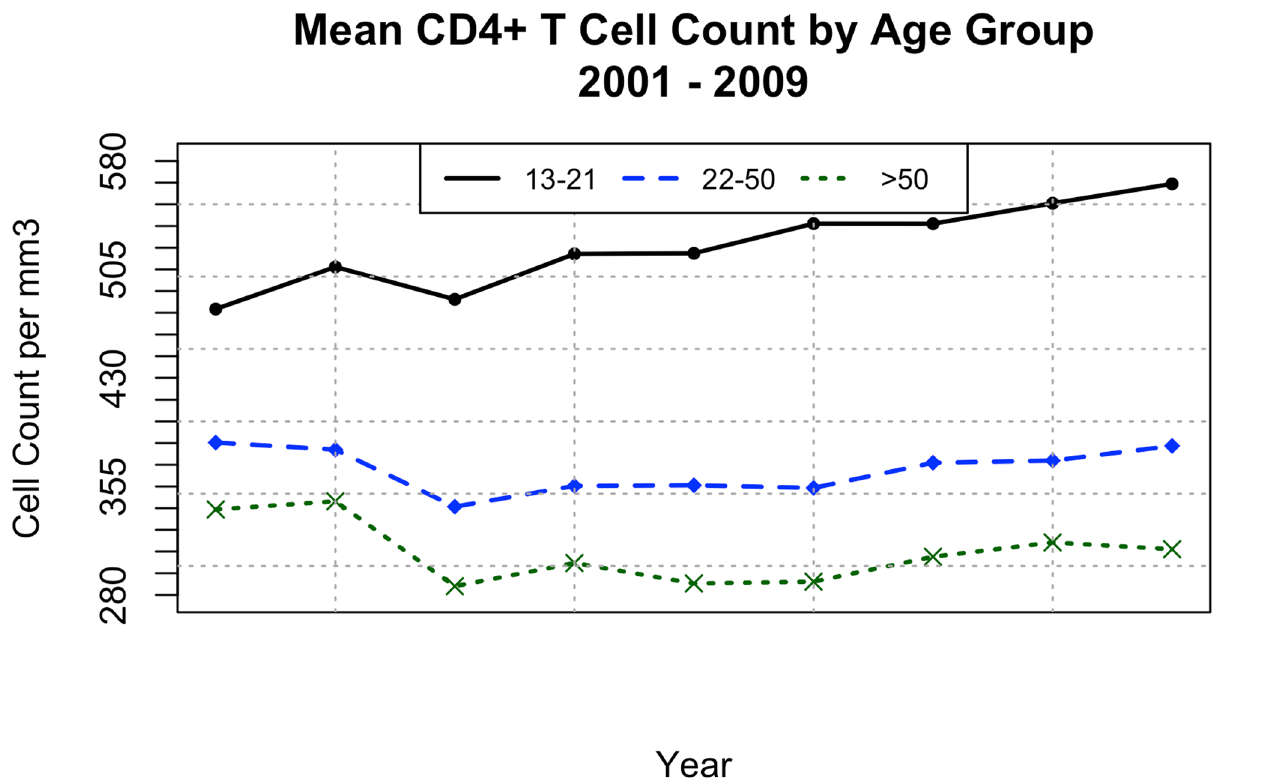
Fig 3. CD4 cell counts by age. Mean CD4+ T cell counts by age according to the first measurement for each patient from 2001 to